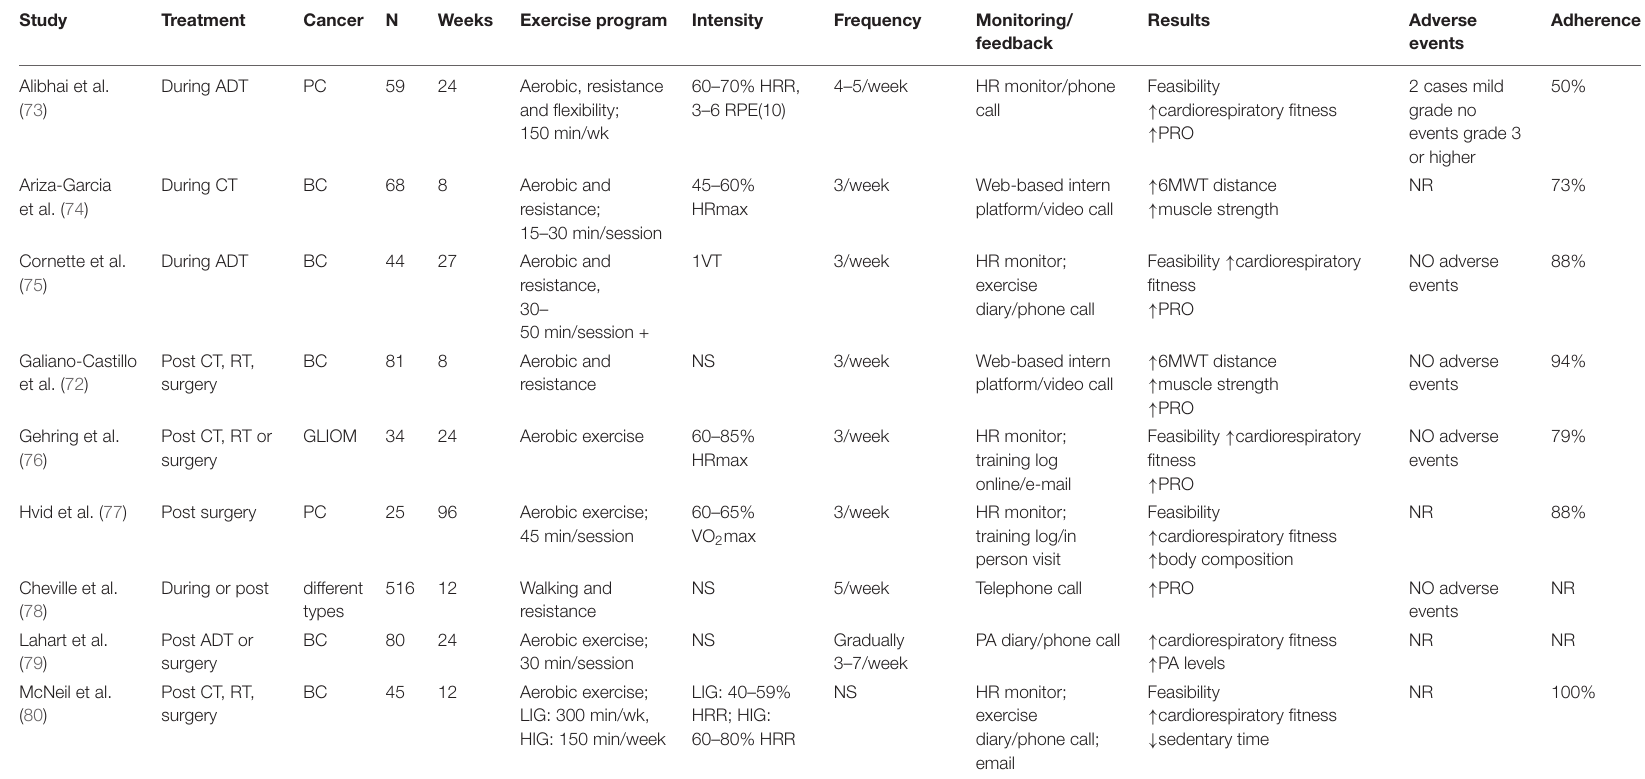
CT, chemotherapy; RT, radiotherapy; HRR, heart rate reserve; HR, heart rate; VO 2 max, maximal oxygen consumption; ADT, androgen deprivation therapy; RPE, rating of Perceived Exertion; VO 2 peak, peak oxygen consumption; HRmax, maximum heart rate; PA, physical activity; VT, ventilatory threshold; LIG, low intensity group; HIG, high intensity group; 6MWT, 6 min walking test; NR, not reported; PRO, patient reported outcomes; BC, breast cancer; PC, prostate cancer; GLIOM,